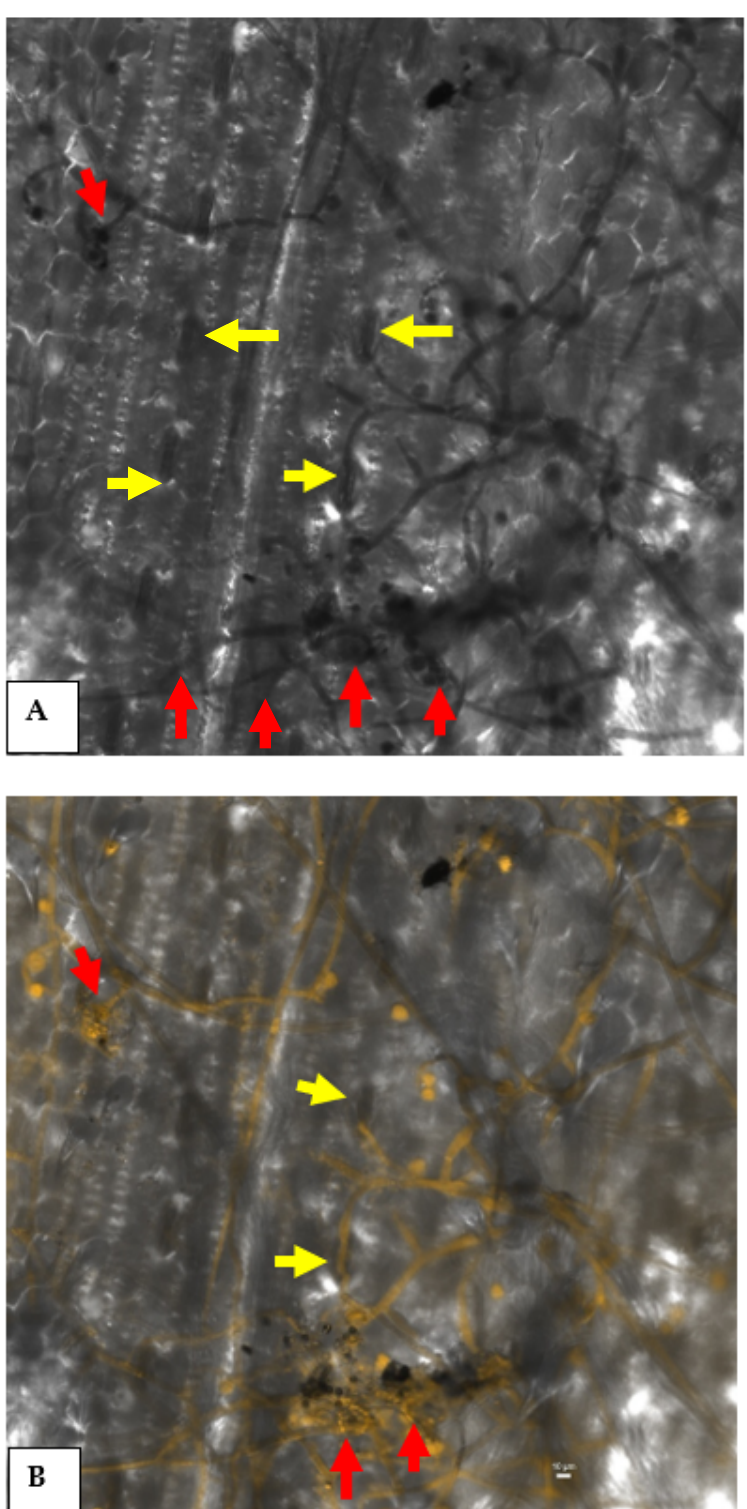
Figure 9. Confocal scanning laser microphotographs showing the colonization and infection of R. solani in maize. The red arrows indicate the formation of infection cushion, and yellow arrows indicate the entry of fungal mycelia through stomata. ( A ) Micrograph in TD channel and ( B ) superimposed image of TD and 488 nm channel together.